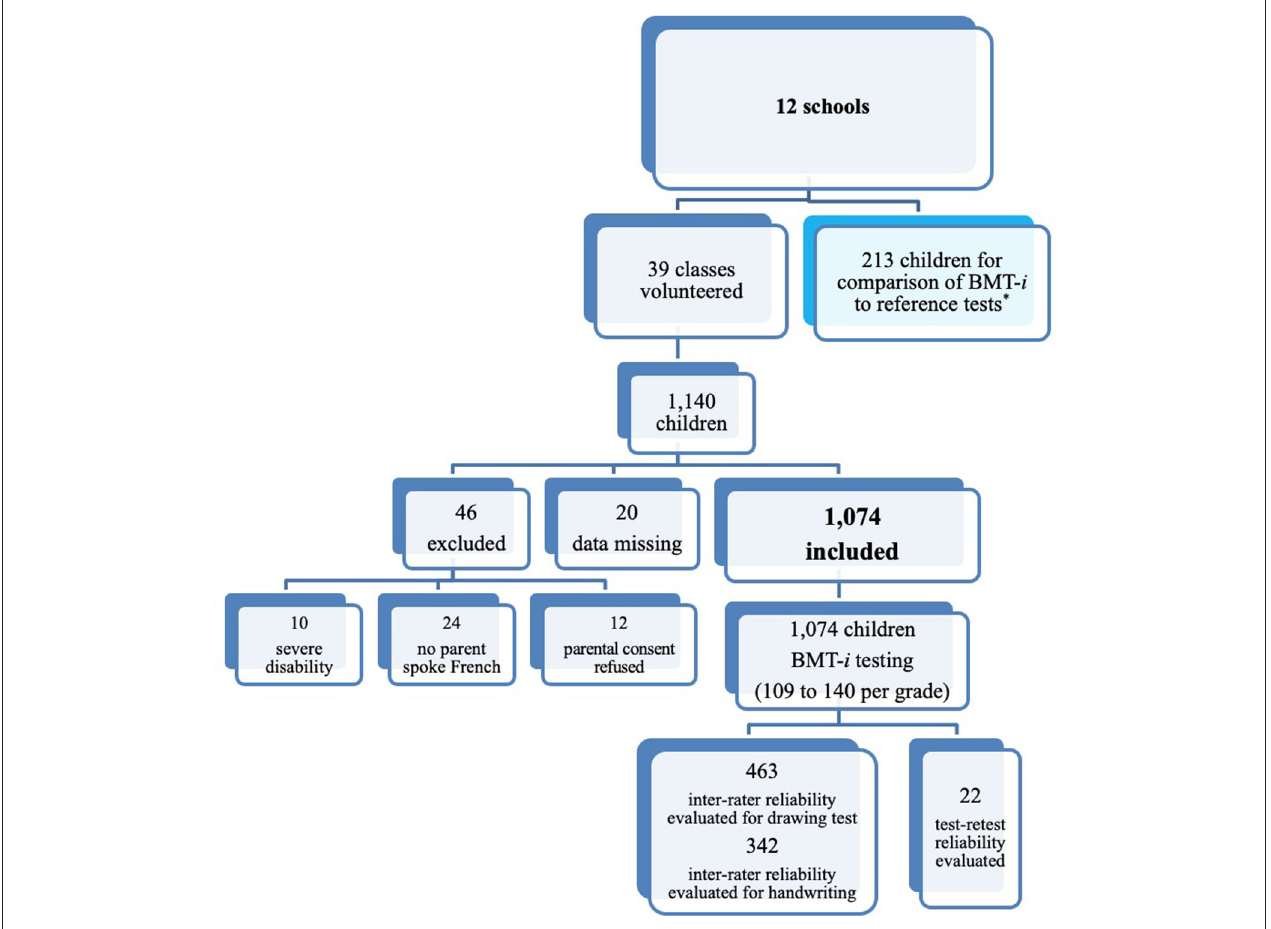
FIGURE 1 | Recruitment of participants. *For comparison with BMT- i tests, reference tests were administered to 213 children: 44 third graders and 96 middle schoolers for written language assessment, and 73 children grades 1–7 for pattern